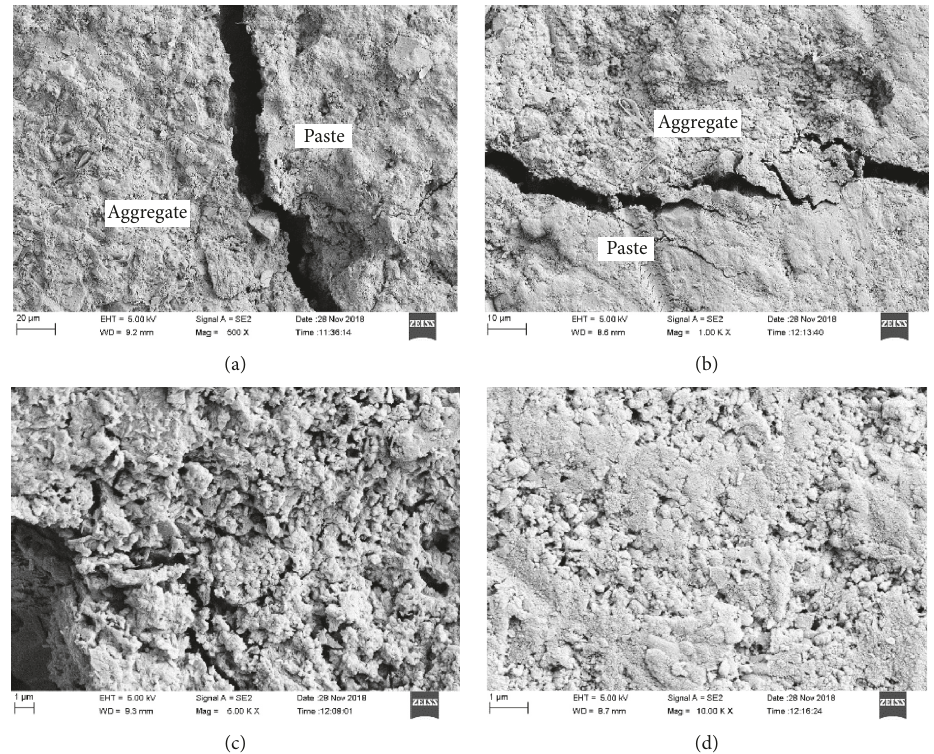
Figure 6: SEM images of interfacial transition zone in (a) RM-YPS-CC and (b) YPS-CC and the paste in (c) RM-YPS-CC and (d) YPS-CC.